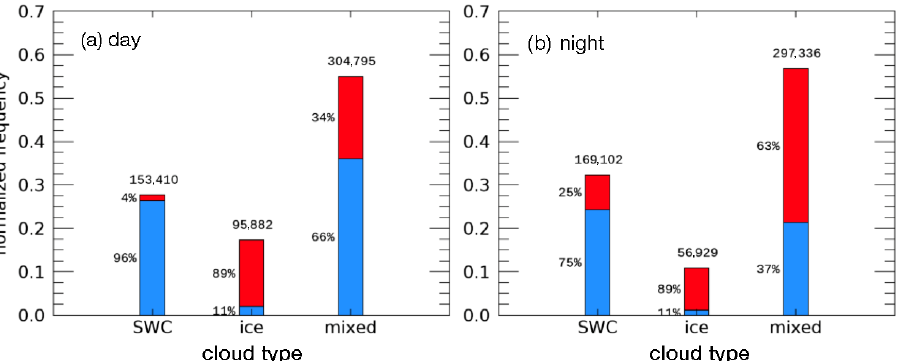
Figure 12. Variation of CV1S ( a ) day and ( b ) night scene identification and phase for multilayer non-opaque cirrus over low clouds as a function of CALIOP cirrus optical depth ( COD u ) using HA ≤ 80 km data collocated within 15 min. Number of samples used as ratio to total CALIOP cases is indicated in the blue box. The asterisks denote the COD u of the median and 90th percentile.